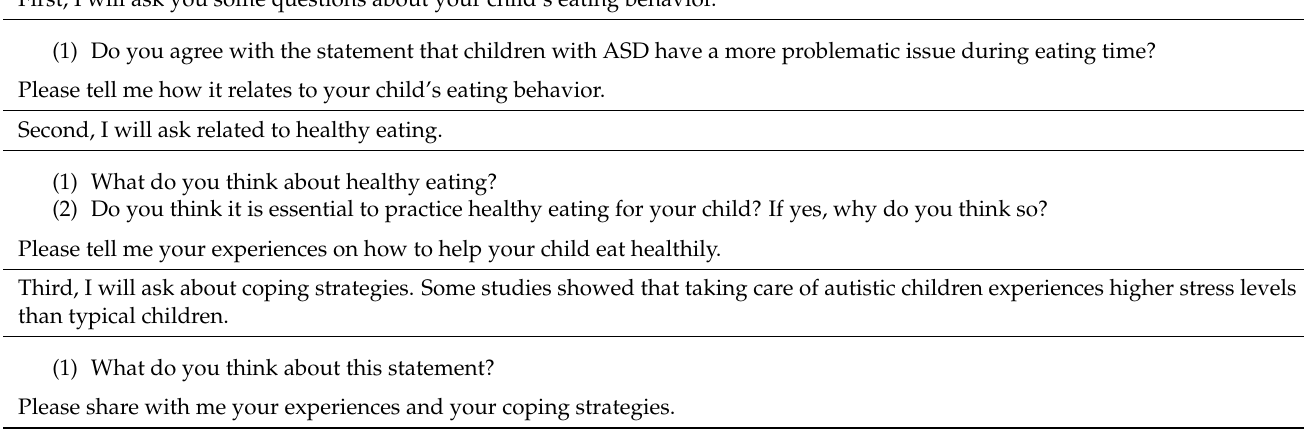
Table 1. Interview guide for the parents with children with